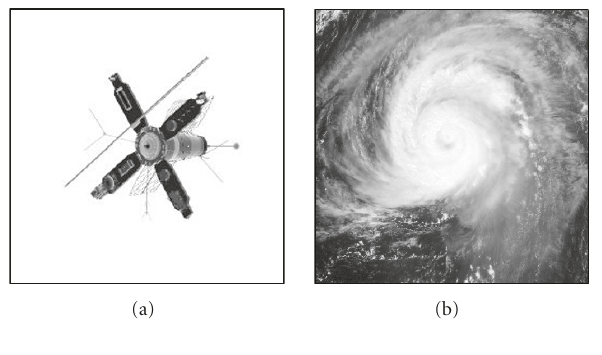
Figure 1: Original